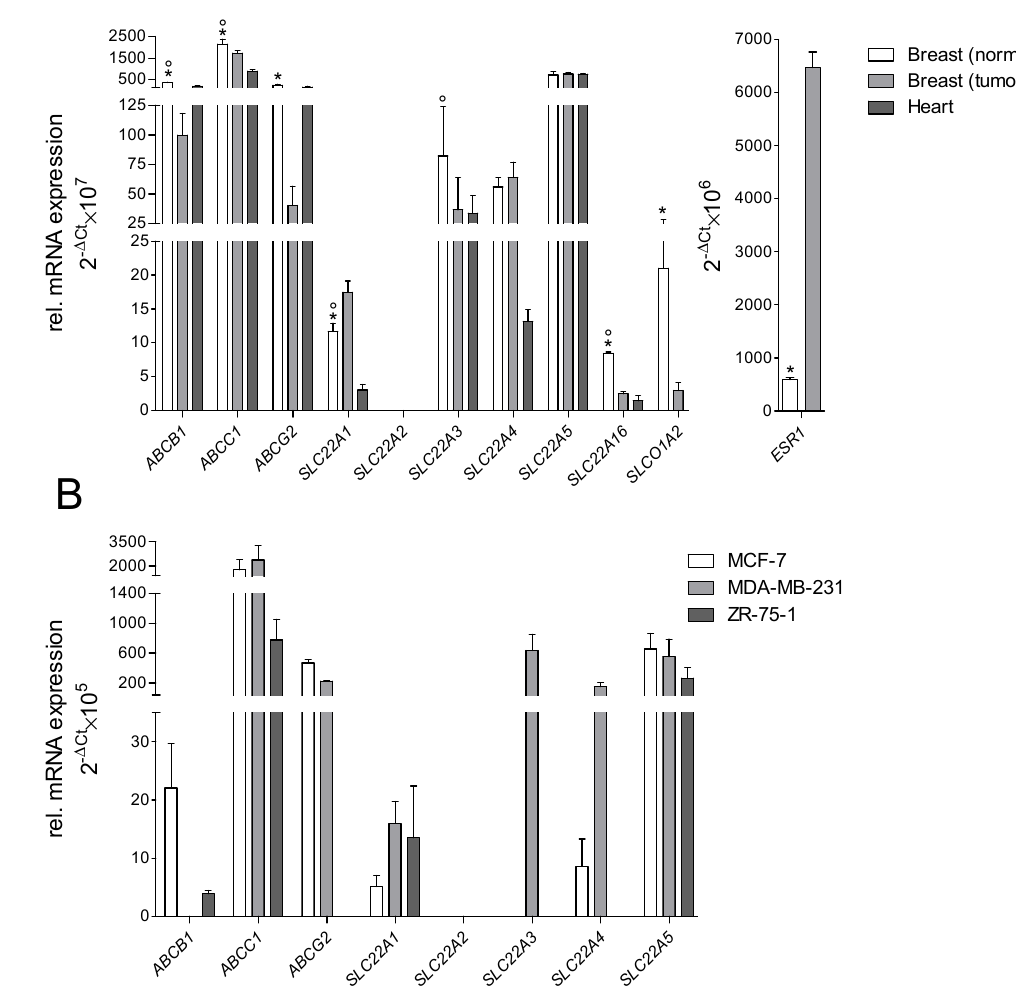
Figure 1. Relative mRNA expression of uptake and efflux transporters: ( A ) in human heart, normal and tumorous breast tissue; 5-donor-pooled sample; ( B ) in breast cancer cell lines MCF-7, MDA-MB-231, and ZR-75-1 (each of 3 measurements in duplicate, reference genes: 18S/GAPDH; * for significant differences between normal and tumorous breast tissue, ° for significant differences between normal breast and cardiac tissue).